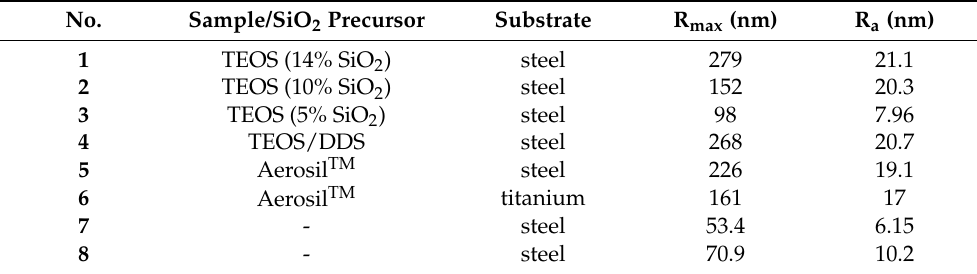
Table 1. The roughness R a and R max indexes of thin films deposited on steel and titanium substrates.